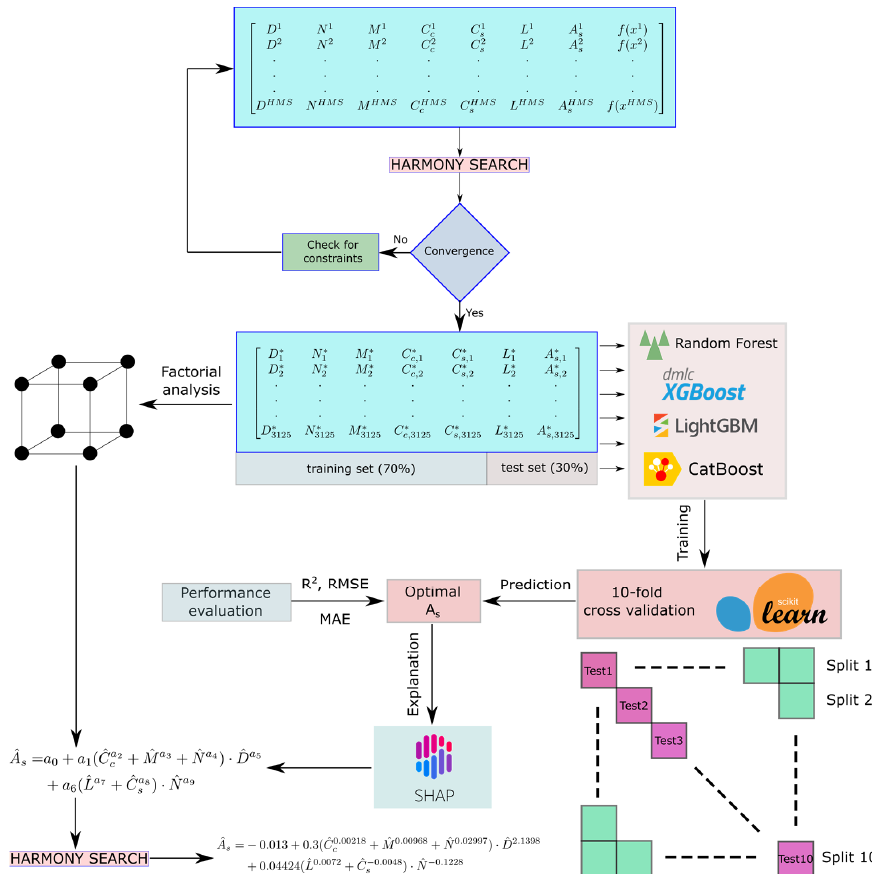
Figure 5. Machine learning and equation development process